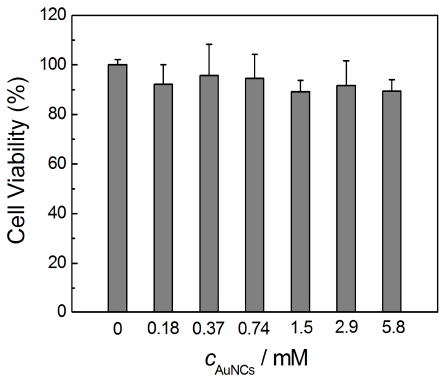
Figure 6. The viabilities of HeLa cells after incubated with different dosages of AuNCs in vitro for 24 h. All the data were collected by conducting three parallel experiments.